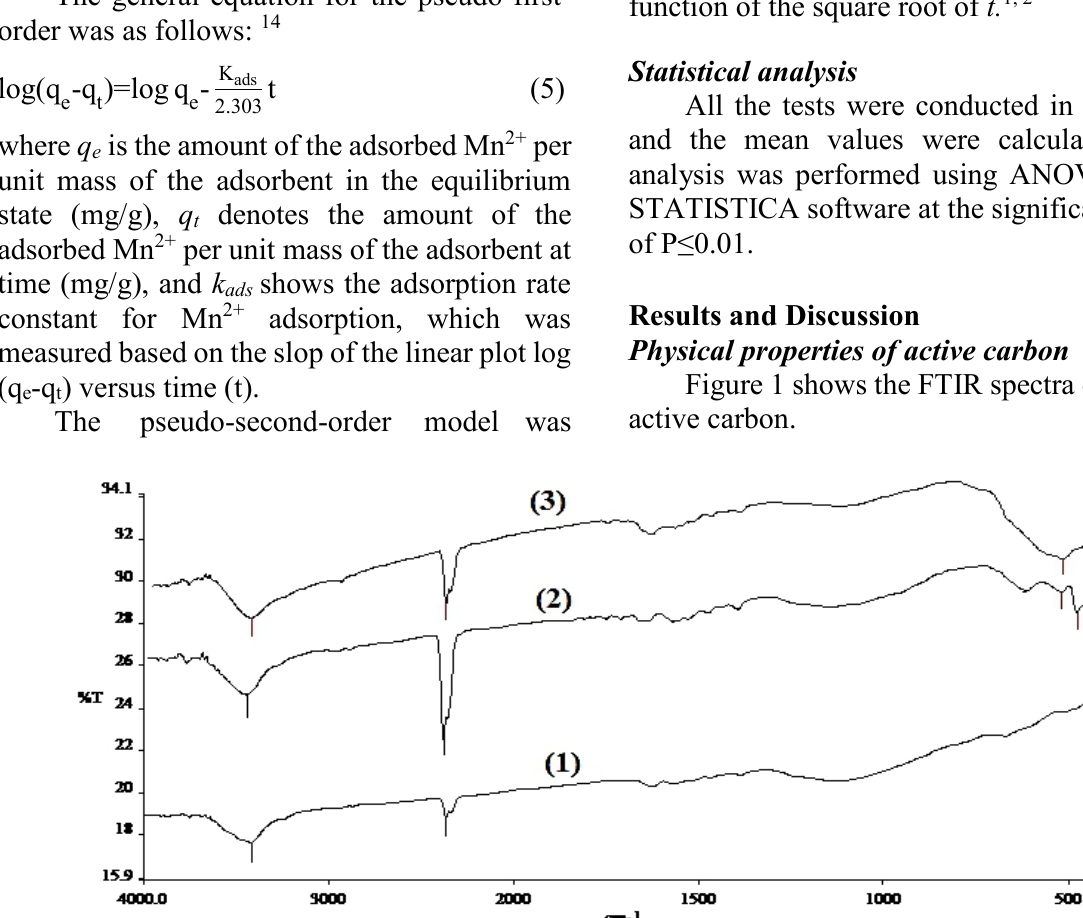
Fig. 1. FTIR spectra of 1) raw active carbon, 2) impregnated active carbon, and 3) impregnated active carbon after